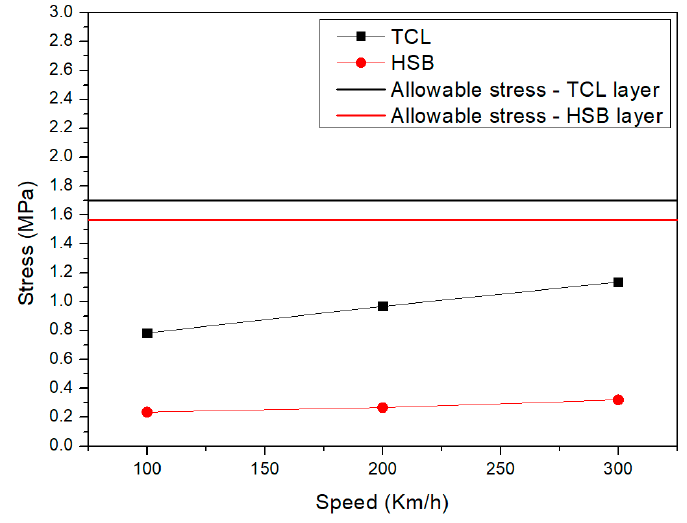
Figure 21. Vertical stress of concrete track by train speeds.